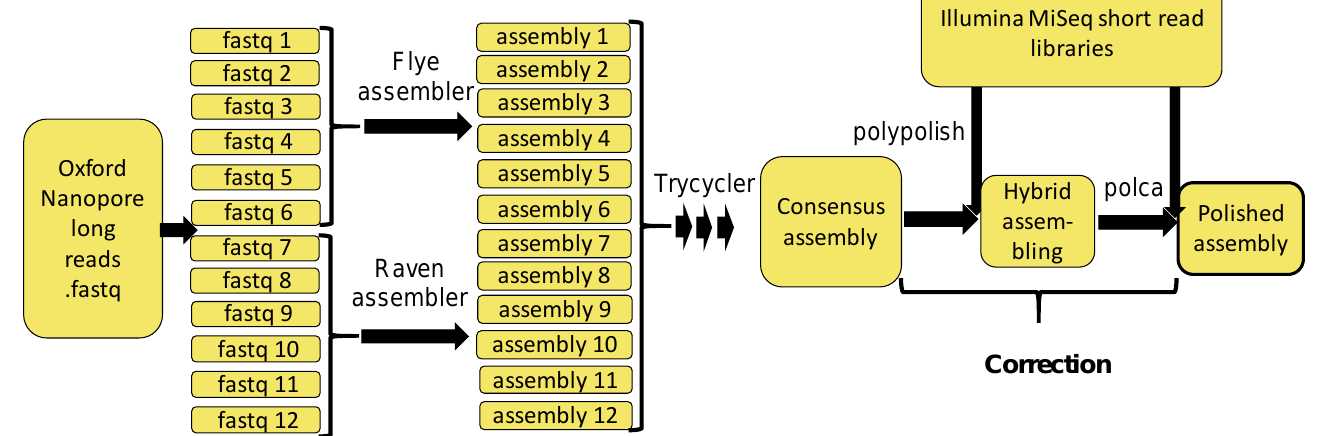
Figure 3. The bioinformatic genome assembly, correction and polishing pipeline used in the current work. Solid lines illustrate the work- and data-flow.